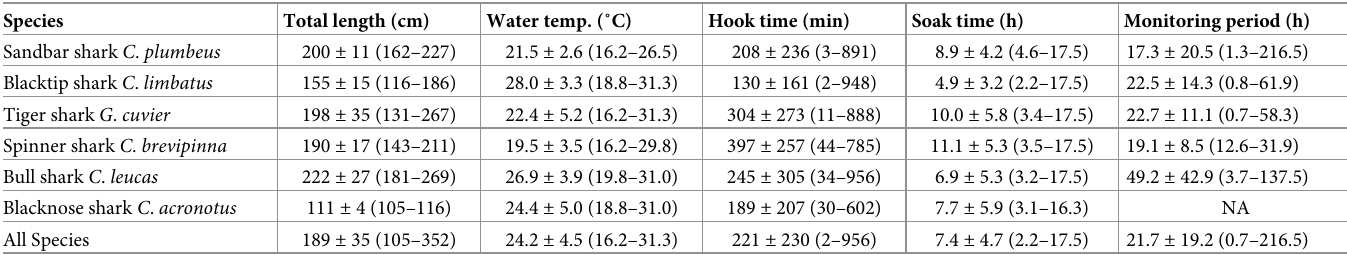
Table 1. Sizes, water temperaures caught, hook times, and acceleration data-logger monitoring periods for all tagged animals.